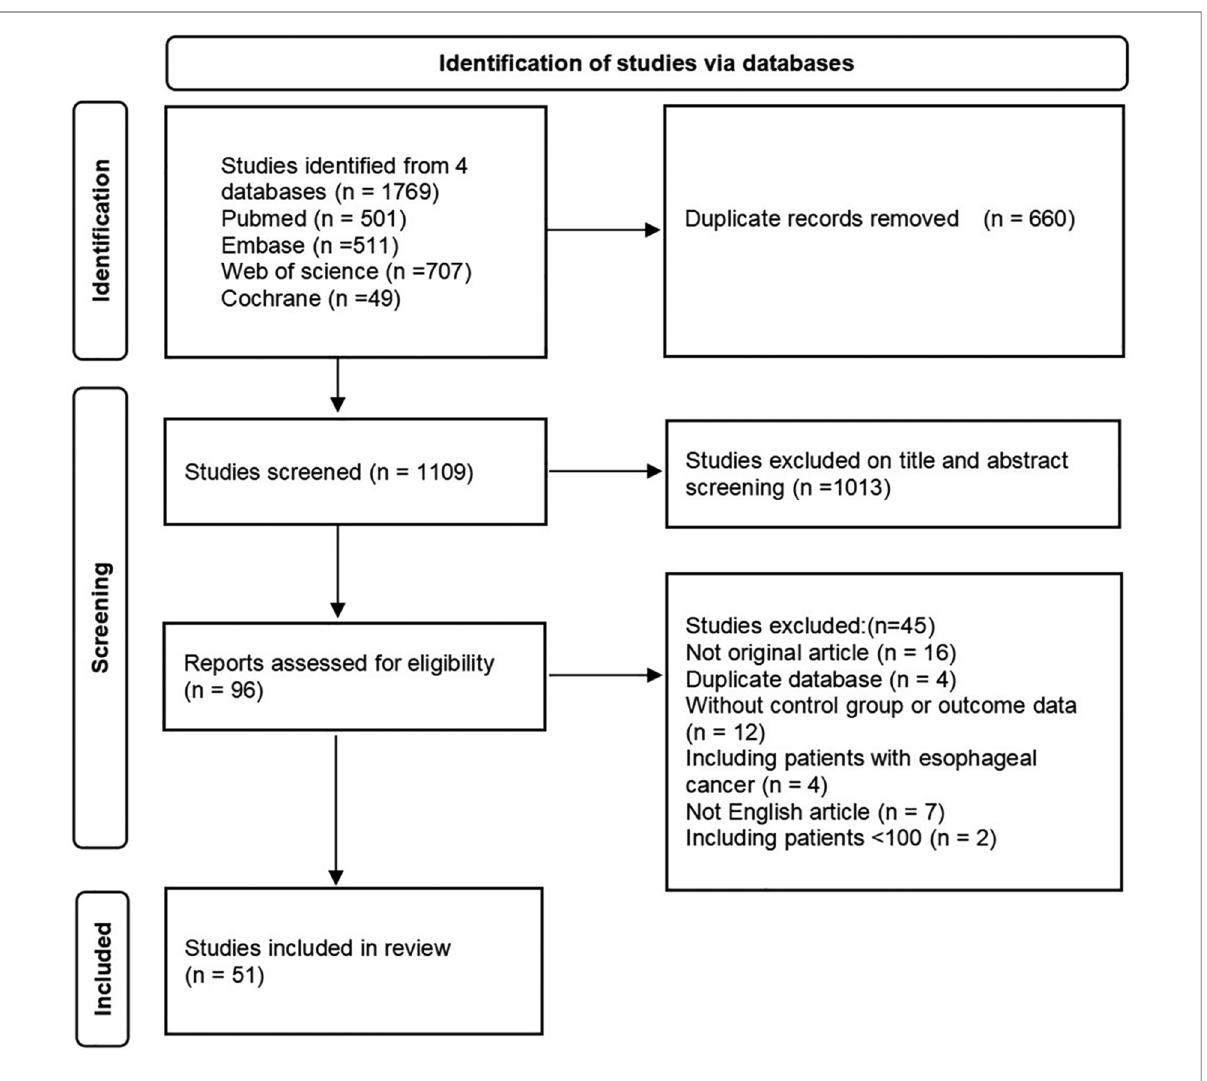
FIGURE 1 Flow chart of the study screening for this